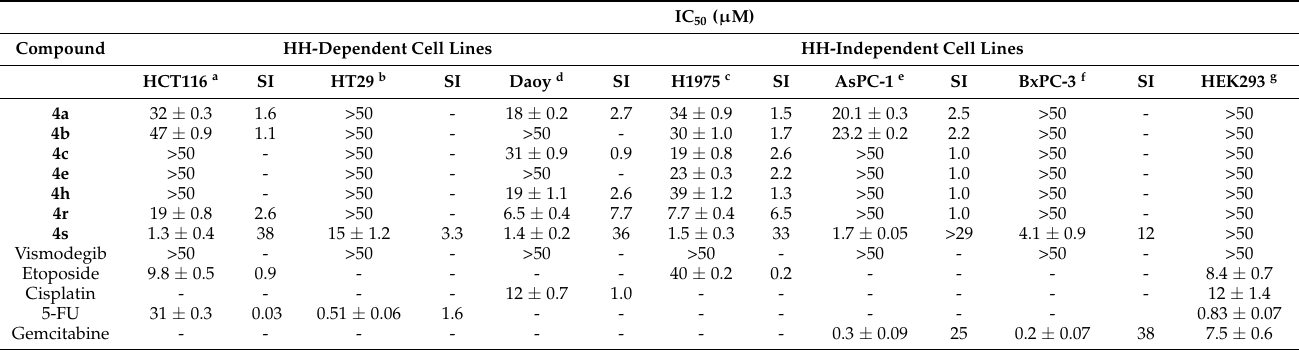
Table 1. In vitro cytotoxicity (IC 50 ) and Selectivity Index (SI) values for maximally active derivatives of purine 4a – 4s on six cancer cell lines and one non-cancer cell